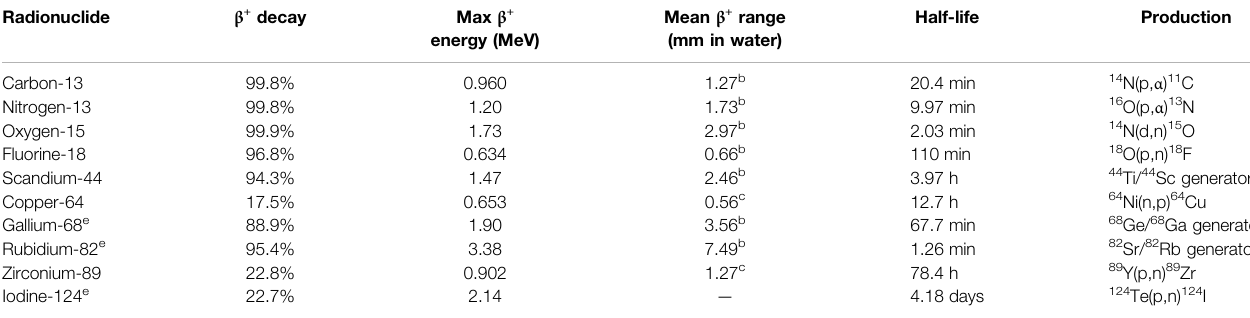
TABLE 1 | Properties of positron emitting radionuclides. a